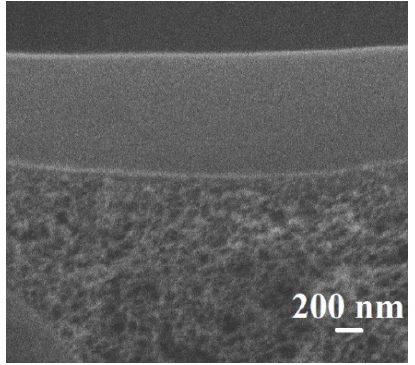
Figure 12. The cross-sectional SEM micrograph of the PVA/GA/PAN membrane. Good adhesion of the PVA/GA layer to the porous PAN substrate and uniform structure of the top thin selective layer is demonstrated. The thickness of the layer is ca. 900 nm. The AFM images with a scan size of 100 × 100 µ m and surface SEM micrographs for the cross-linked composite PVA and PVA/Zr-MOFs(10%) membranes are presented in Figure